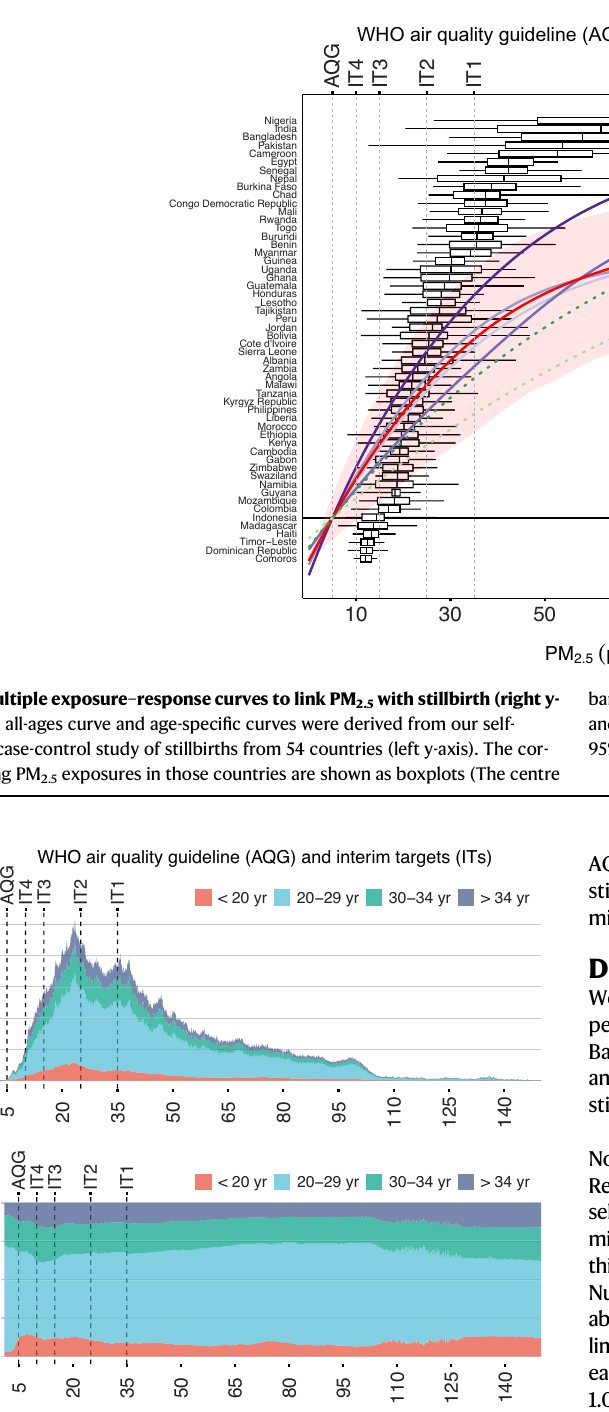
Fig.3|PM 2.5 exposuredistributionamongthe137countries. Distributions(top) and relative fractions (bottom) of age-speci fi cpopulations at risk (i.e., pregnancies strati fi ed by maternal